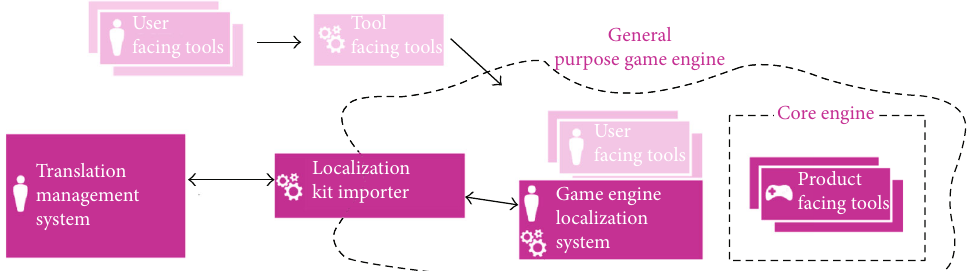
Figure 7: A proposed model of a localization-friendly game production